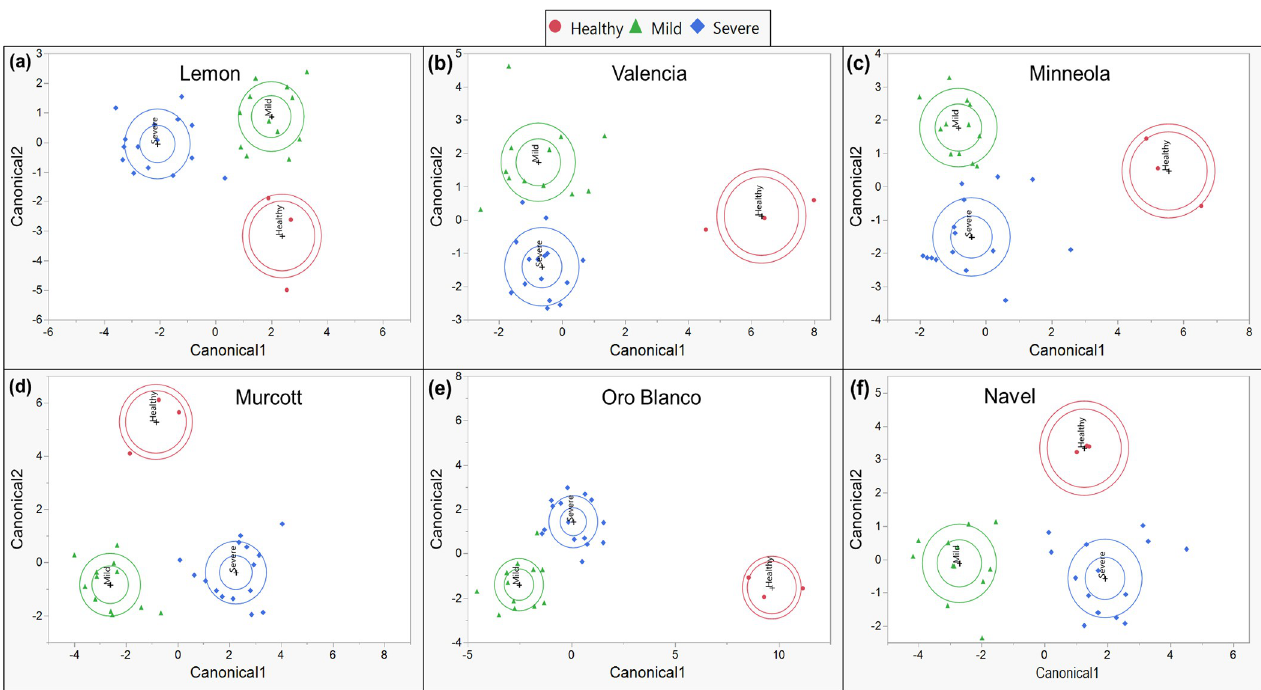
Fig 8. Canonical plots using 10 most variable individual phenolic compounds. Canonical plots of different plants displaying mild (green-triangle), severe (blue-diamond), or no (red-circle) symptoms after CTV- or mock-inoculation, within each citrus cultivar. Canonicals were generated by stepwise discriminant analysis utilizing the 10 most variable phenolics between differentially infected plants of each cultivar. Outer ellipses are estimated 50% of the samples within a cultivar, and inner ellipses show the 95% confidence region of cultivar means. https://doi.org/10.1371/journal.pone.0268255.g008 Table 3. CDA utilizing phenolics. Predicted Count